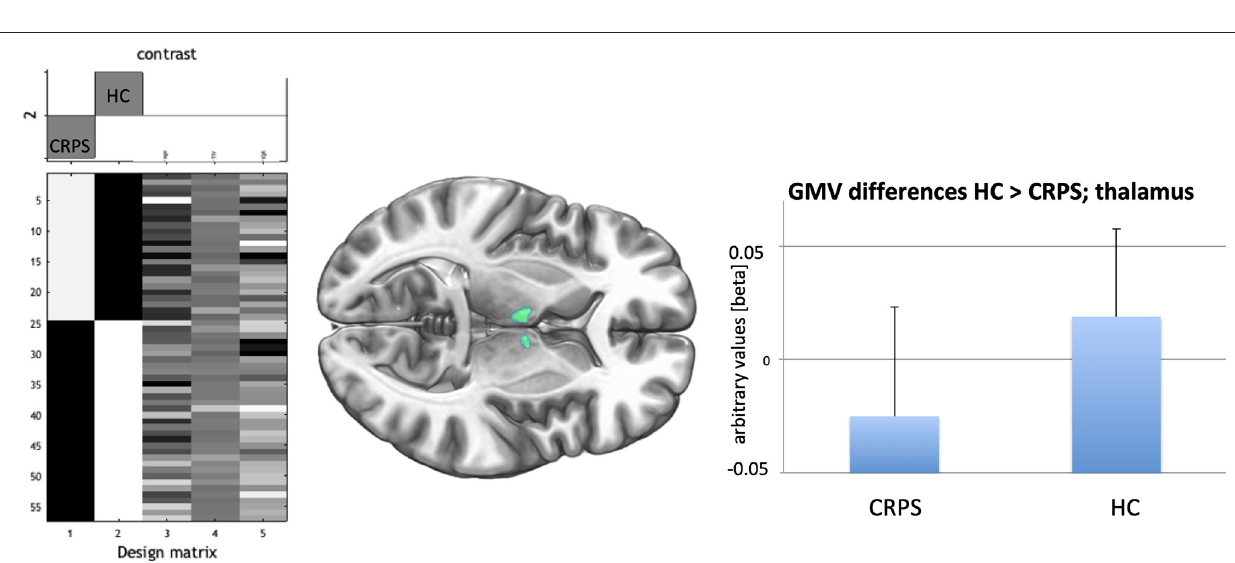
for the patients GMV in the medial parts of the